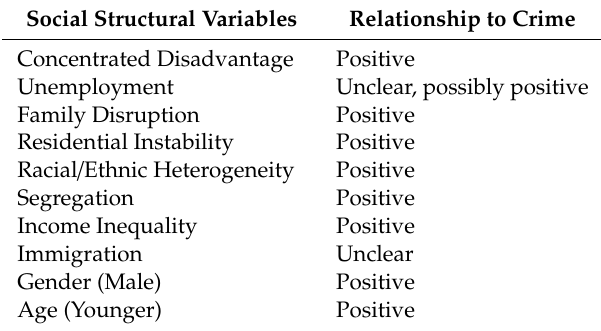
Table 1. Direct and indirect e ff ects of variables on urban crime